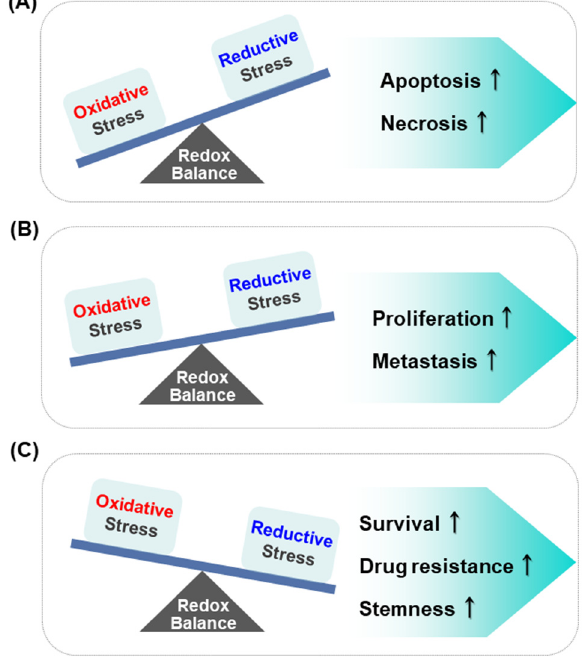
Figure 2. Effect of different levels of redox balance on the regulation of cellular processes in cancer cells. Oxidative stress, if extremely high, is cytotoxic ( A ), whereas moderate concentration of ROS induces the proliferation and metastasis of cancer cells ( B ). Reductive stress caused by low levels of ROS generation might lead to cancer cell survival, resistance to cancer therapy and stemness of cancer cells ( C ).